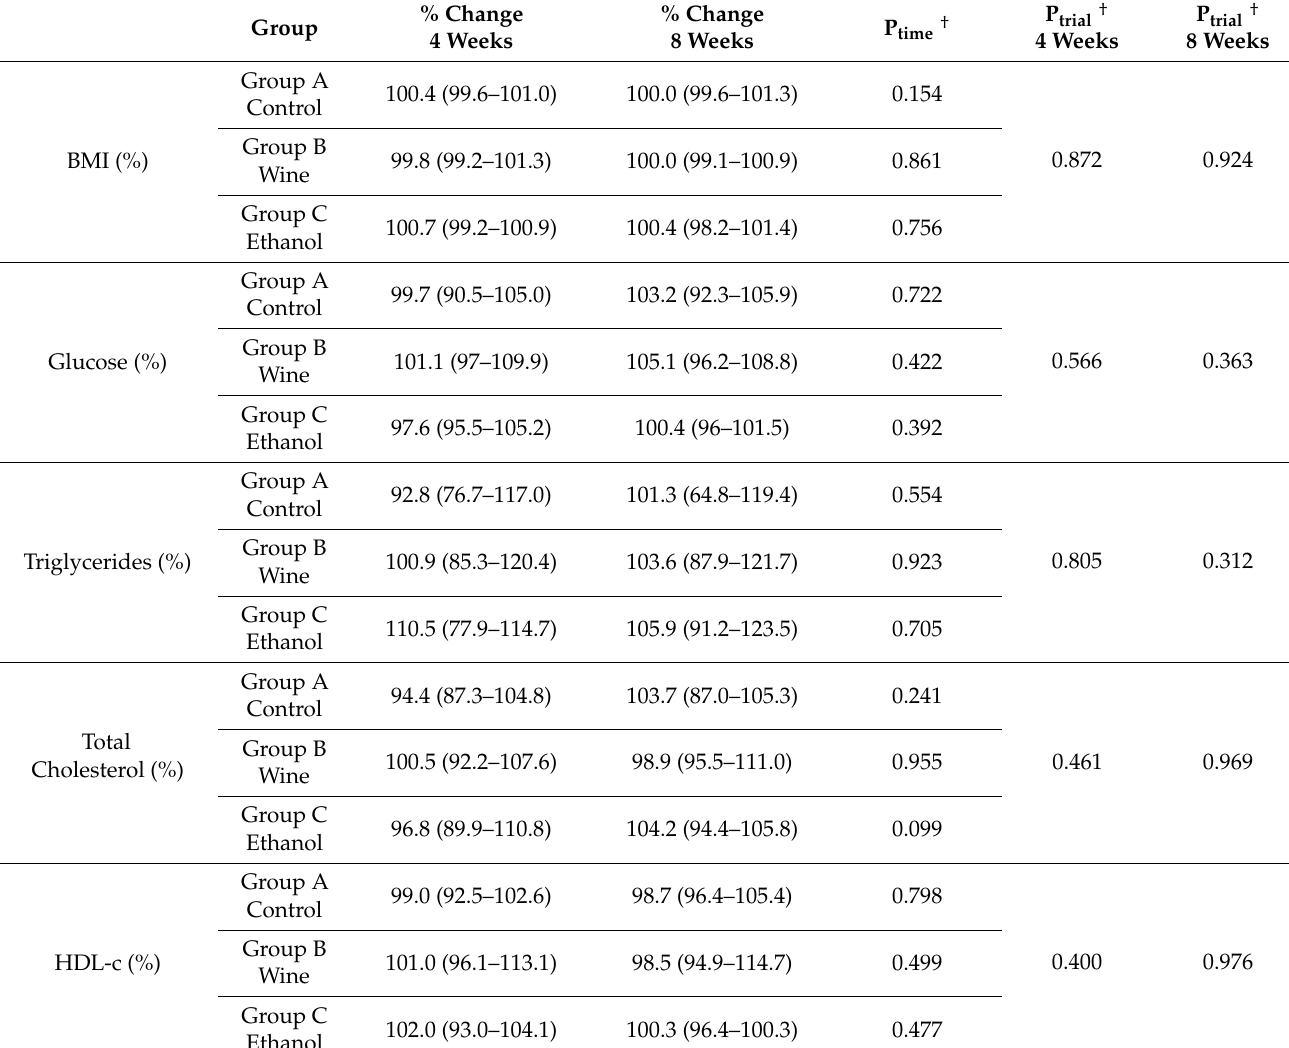
Table 3. % Change of baseline values in basic biochemical and anthropometric